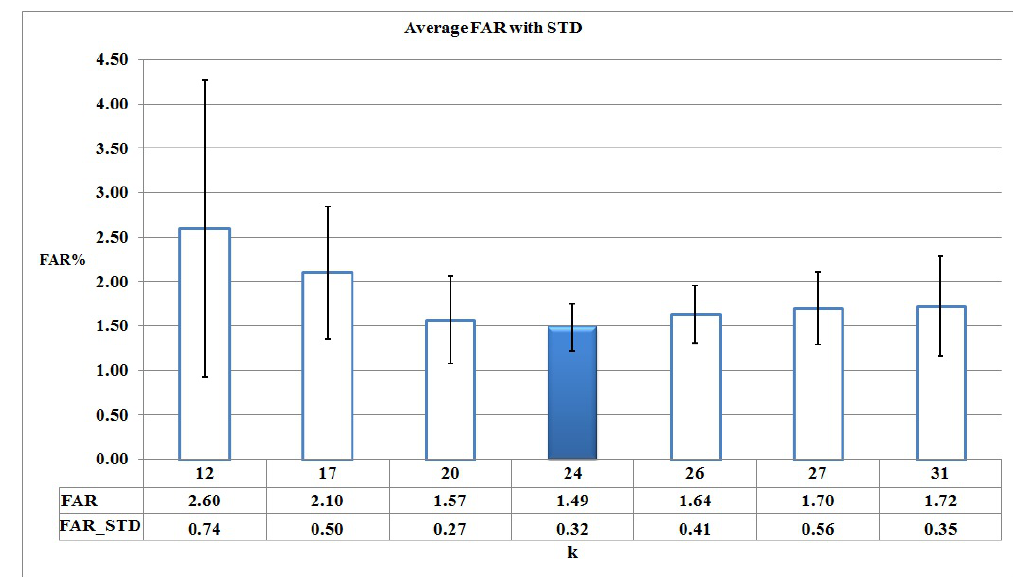
Figure 6. FAR for different candidate values of k based on Figure